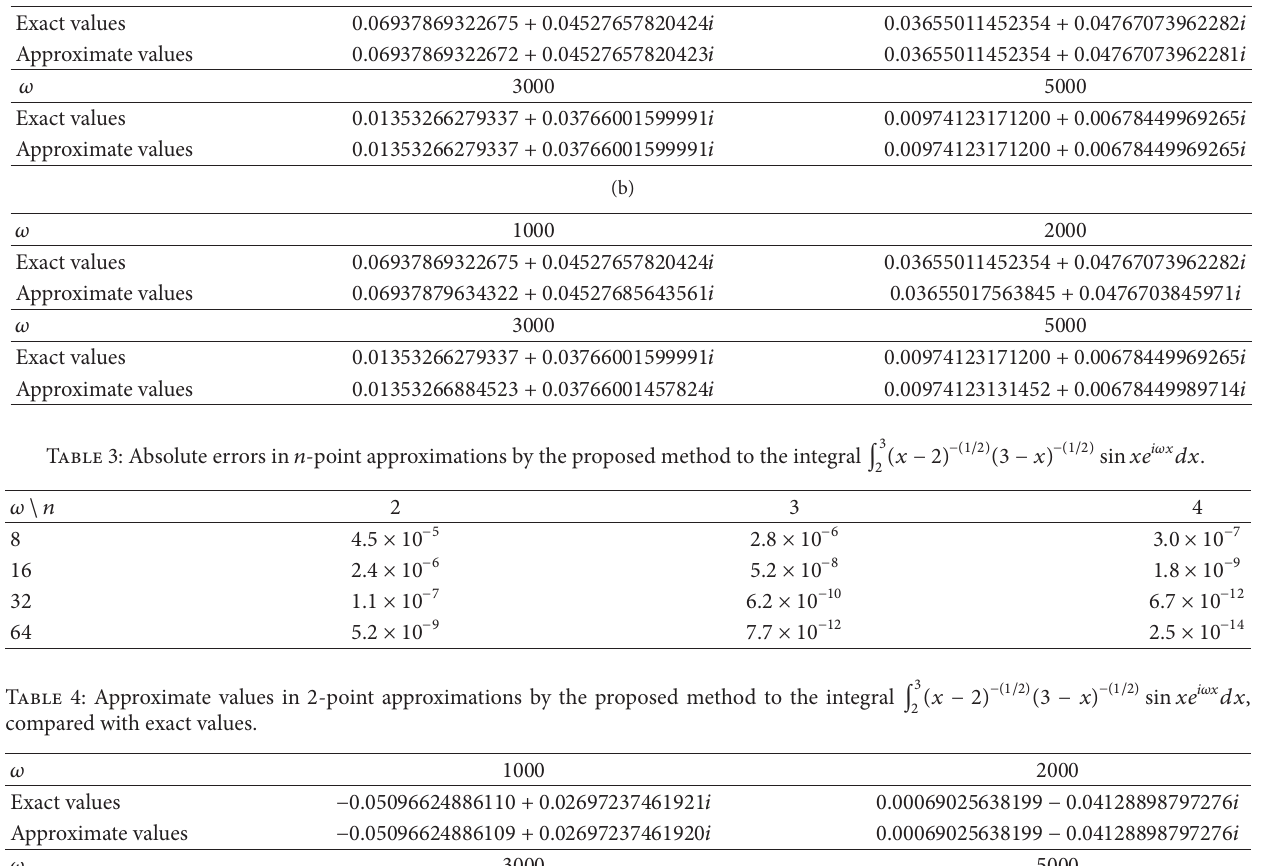
Table 5: Absolute errors in 𝑛 -point approximations by the proposed method to the integral ∫ 𝜔 \ 𝑛